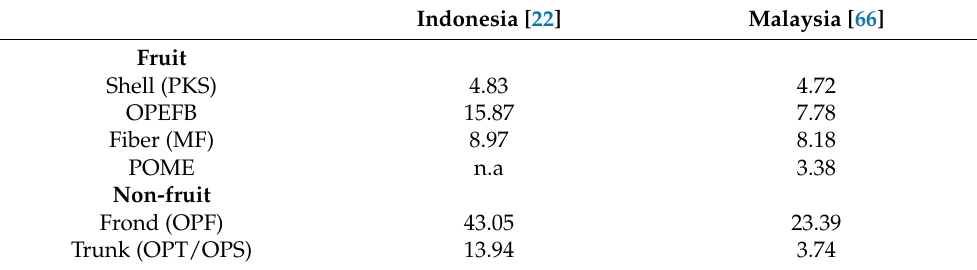
Table 2. Biomass residue of oil palm in two countries, Indonesia and Malaysia, that are derived from the fruit and non-fruit (million